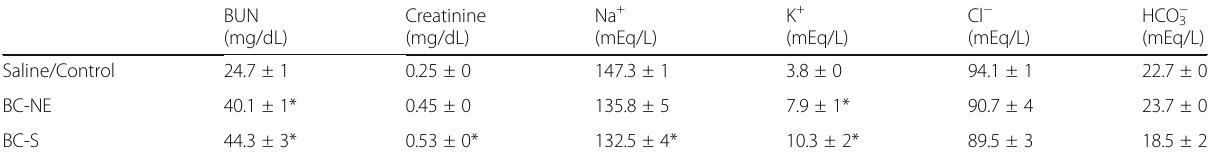
Table 1 Plasma electrolyte, BUN and creatinine levels 3 h following administration of Malayan krait venoms (50 μ g/kg, i.m.) from different populations or saline (50 μ L, i.m.)